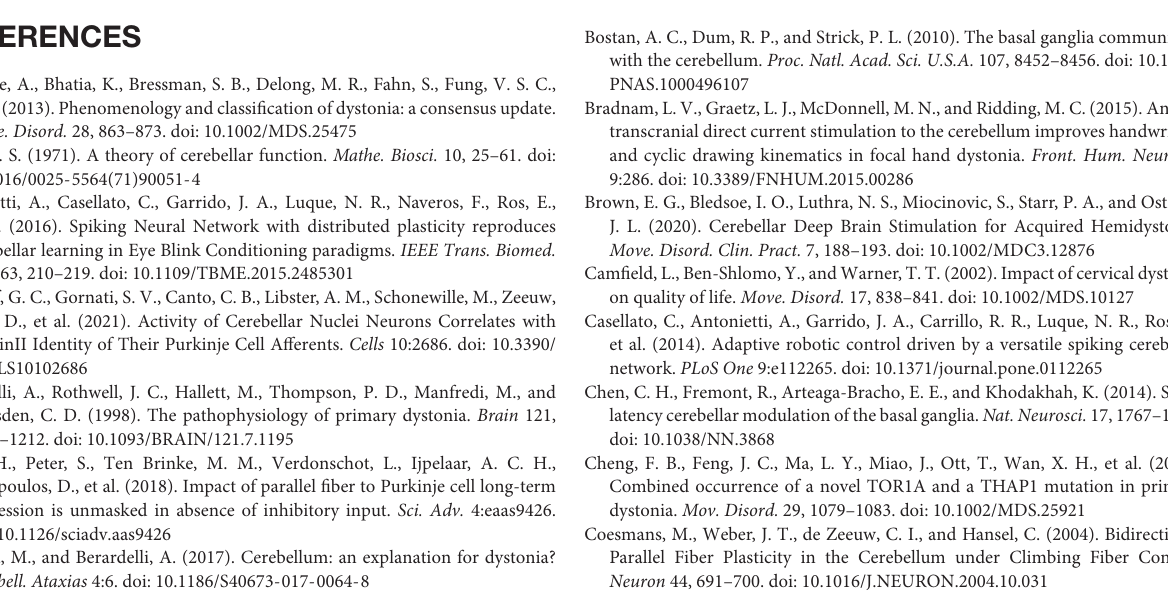
Supplementary Figure 2 | SDFs of downstate (A) and upstate (B) individual PCs, undergoing a significant SDF change (suppression/facilitation), in the last trial with respect to initial state (first 100 ms from CS onset) in the control condition. The thicker lines represent the average across cells. The frequency values are normalized with respect to the initial state activity (horizontal dashed lines at 0 Hz). Supplementary Figure 3 | Baseline firing rate (A) , and irregularity measured through the CV ISI (B) of PCs (left) and DCN (right) in the case of reduced olivocerebellar input for the three damage levels, compared to the control condition. Cyan horizontal line indicates the mean, red horizontal line indicates the median, box edges – 1st and 3rd quartile, whiskers – minimum and maximum accepted values, excluding outliers (indicated as circles). Supplementary Figure 4 | Raster plots showing spiking activity of each cell (y axis) within PC population in the first trial of simulations with aberrant PC burst-firing, intrinsic (A) and IO-induced (B) . Gray vertical lines represent the CS onset and end, purple line marks the US onset. Supplementary Figure 5 | Baseline firing rate (A) and irregularity measured through the CV ISI (B) of PC (left) and DCN cells (right) in the case of intrinsic and IO-induced PC burst-firing, compared to the control condition. Cyan horizontal line indicates the mean, red horizontal line indicates the median, box edges – 1st and 3rd quartile, whiskers – minimum and maximum accepted values, excluding outliers (indicated as circles). Supplementary Figure 6 | Baseline firing rate (A) and irregularity measured through the CV ISI (B) of PC (left) and DCN cells (right) in the case of imbalanced PC synaptic densities, for mild and severe damage levels, compared to the control condition. Cyan horizontal line indicates the mean, red horizontal line indicates the median, box edges – 1st and 3rd quartile, whiskers – minimum and maximum accepted values, excluding outliers (indicated as